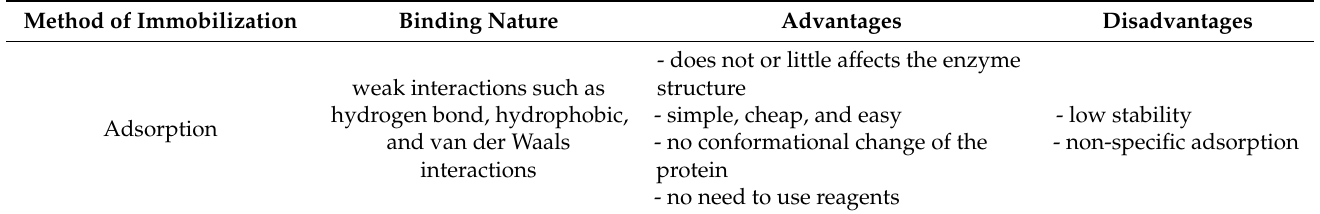
Table 2. Advantages and disadvantages of most commonly known immobilization methods [114,118,119]. Method of Immobilization Binding Nature Advantages Disadvantages